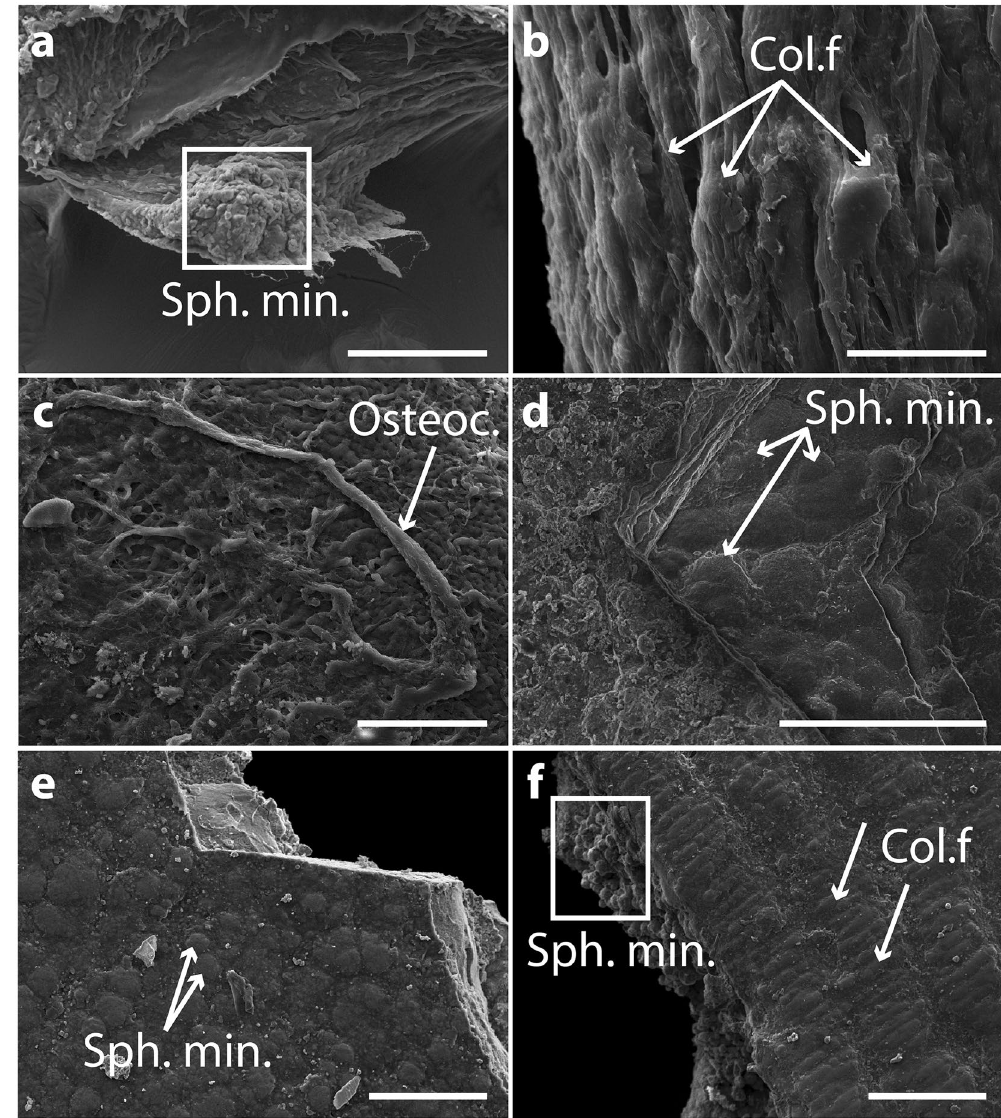
Figure 3. Scanning electron microscopy of extant and fossil coelacanth lung plates. ( a ) SEM image revealing the presence of spherules of spheritic mineralisation in a lung plate of Latimeria chalumnae (adult specimen CCC 24). Boxed area indicates spherules. ( b ) SEM image of a Latimeria chalumnae lung plate (adult specimen CCC 79) showing collagen fibres (white arrows). ( c ) SEM image of mineralised portion of a lung plate of Latimeria chalumnae (adult specimen CCC 79); white arrow indicates cytoplasmic processes departing from potential osteocytes. ( d ) SEM image of an Axelrodichthys araripensis lung plate (‘Josa collection’); white arrows indicate spherules of spheritic mineralisation. ( e ) SEM image of a Swenzia latimerae lung plate (MNHN.F.JRE 47); white arrows indicate presence of spherules characterizing spheritic mineralisation. ( f ) SEM image of a Swenzia latimerae lung plate (MNHN.F.JRE 47); boxed area indicates spherules characterizing spheritic mineralisation; white arrows indicate collagen fibres. Col. f., collagen fibres; sph. min., spheritic mineralisation; osteoc., osteocytes. Scale bars, 100 µ m ( a , d ) 20 µ m ( b ) 50 µ m ( c , e , f